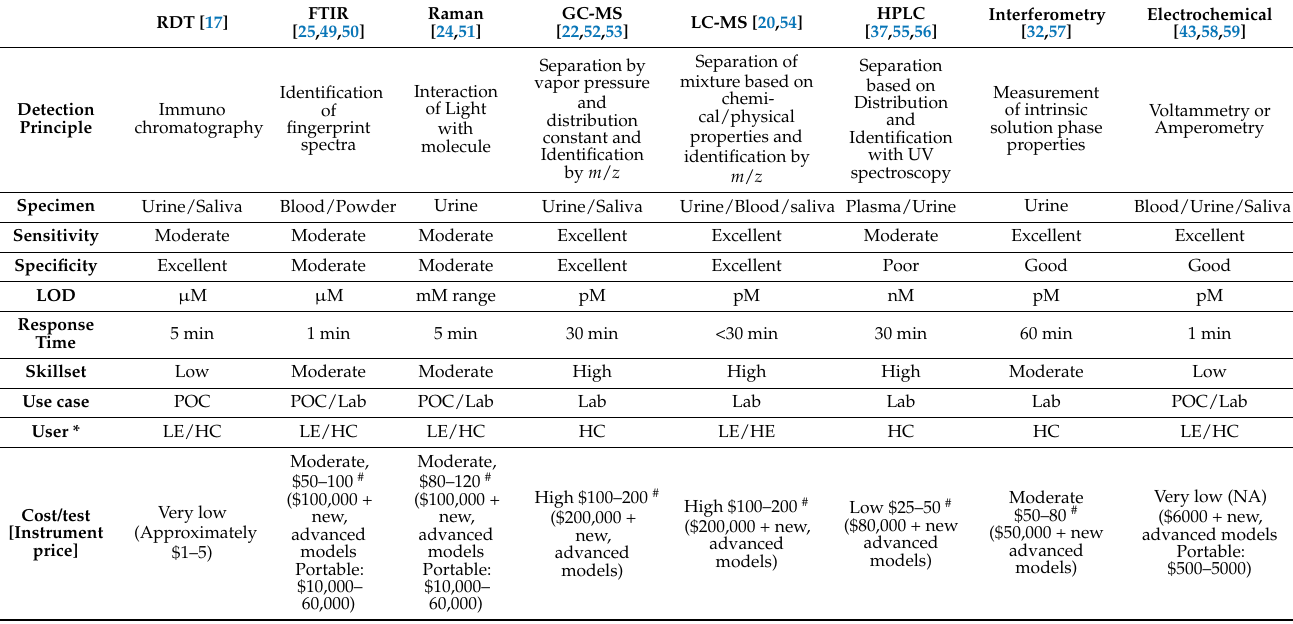
Table 1. Summary of opioid detection